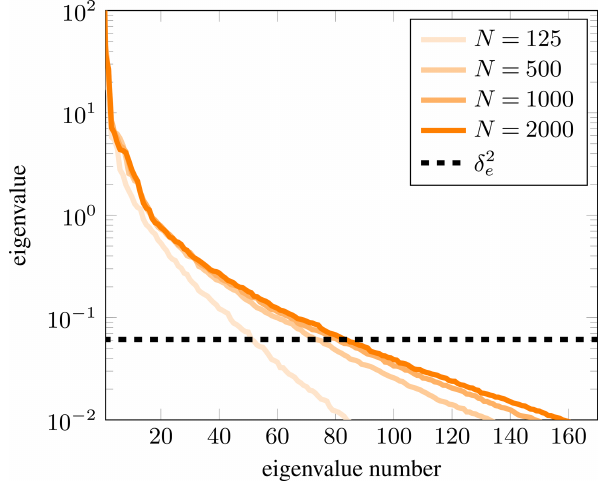
Figure 11. Spectrum of (cid:48) ε for various sample sizes, N , for Exam- ple 3, along with the noise variance, δ 2 e .